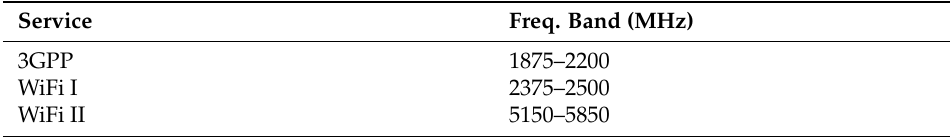
Table 1. Services and Frequency Bands.